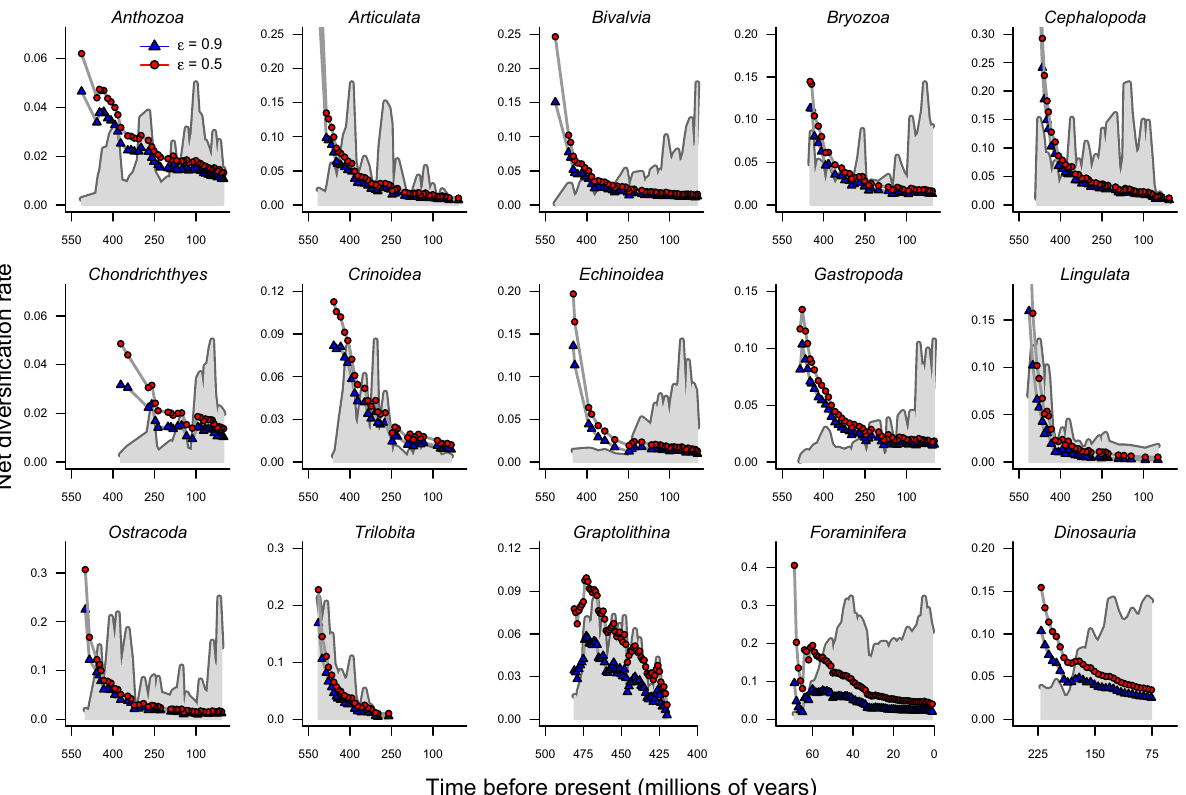
Fig. 2 Time-scaling of ARR rates. ARR estimates of net diversi fi cation rate decrease sharply through time as a function of the timescale over which they are computed. For each timepoint, rates were computed using an estimate of stem clade age and the standing diversity at the focal time, as in Fig. 1 a – c Rates were computed using relative extinction rates of 0.5 (red circles) and 0.9 (blue triangles), which are widely used in neontological studies. Gray polygons show the underlying diversity trend for each clade on a proportional scale (see Supplementary Fig. 2 for actual values). The decay in rates occurs regardless of the form of the underlying diversity trend. Clades that increased in diversity through time (e.g., Bivalvia, Gastropoda, Dinosauria) show the same general pattern as extinct or declining clades. This temporal decay in rates is the expected pattern under null models where species richness fl uctuates randomly in time with no underlying biological process (Supplementary Fig.